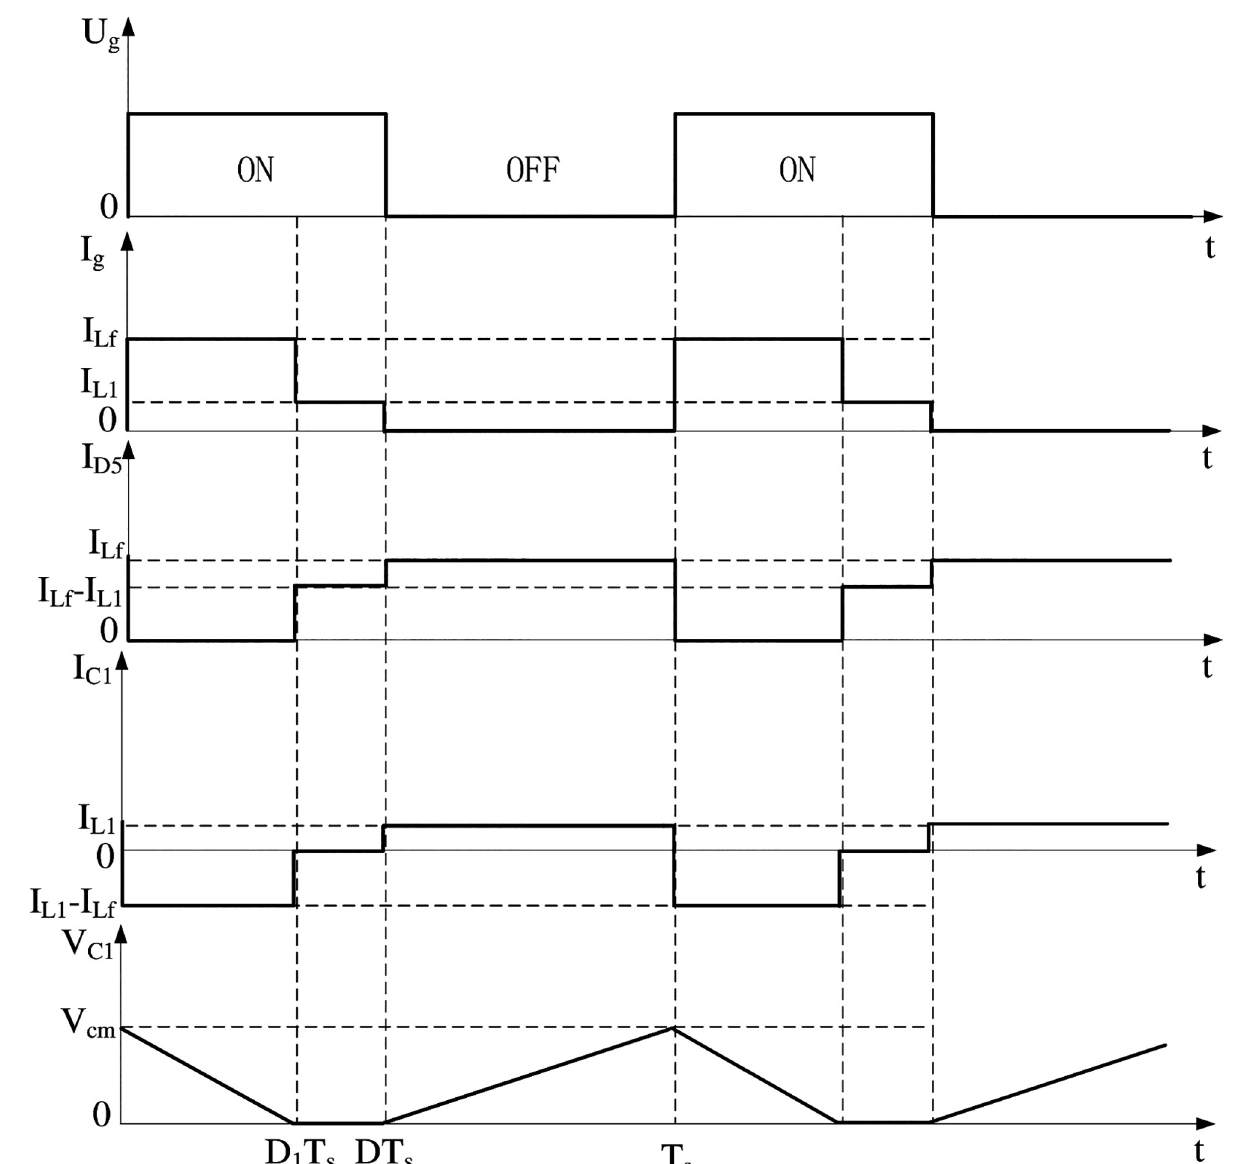
Fig 2. Working waveforms of Buck PFC circuit in DCVM